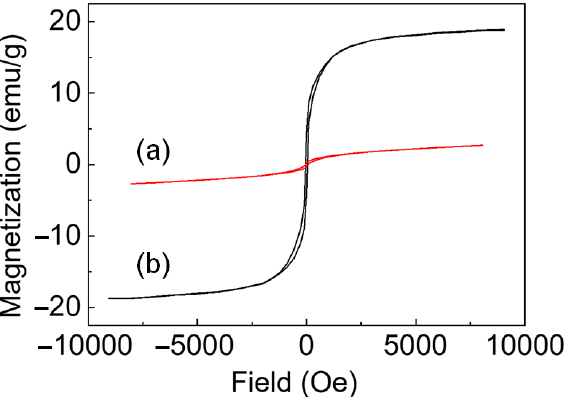
Figure 3. Magnetization ( M )–magnetic field ( H ) curve for Ni nanoparticles measured by SQUID at 5 K for ( a ) 13 nm and ( b ) 18 nm Ni nanoparticles. To obtain nanoparticles with high magnetism, both the crystallinity and size of the particles should be increased while reducing the amount of impurities. When a smaller amount of phosphine was used, larger particles with high crystallinity and fewer impuri- ties were obtained. Because phosphine molecules can induce the decomposition of the Ni–